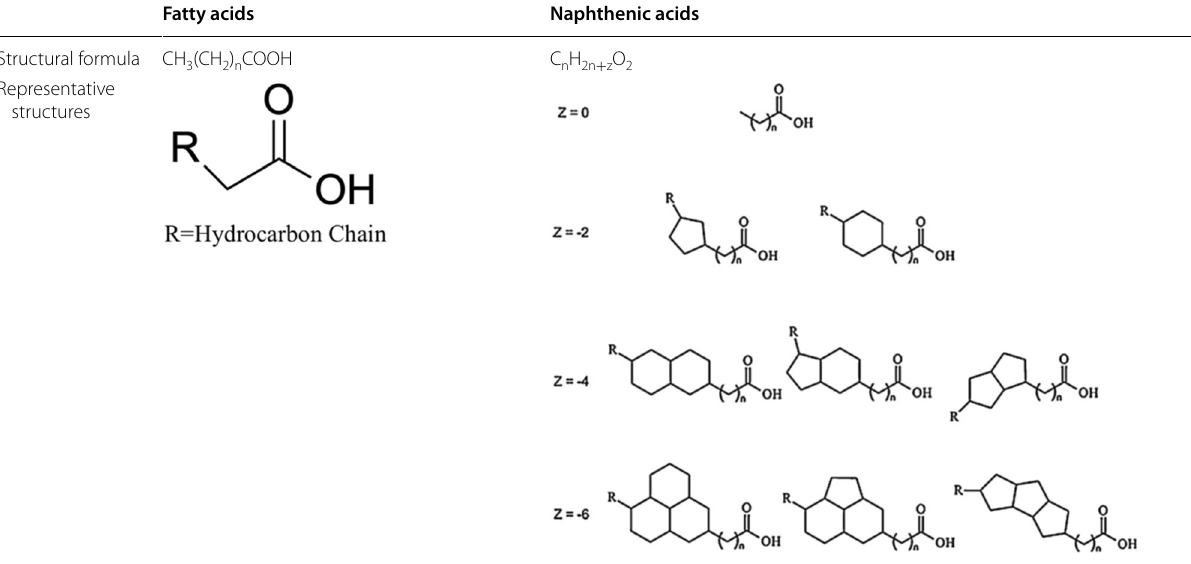
Table 3 Comparison between fatty acids and naphthenic acids (Shang et al. 2013) Fatty acids Naphthenic acids Structural formula CH 3 (CH 2 ) n COOH Representative